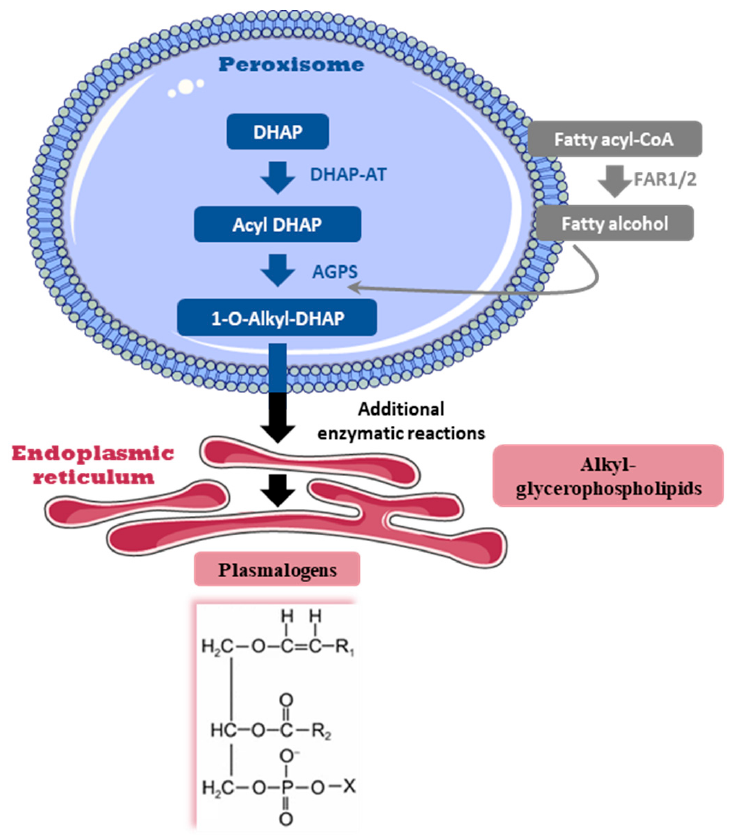
Figure 1. Schematic representation of plasmalogen biosynthesis. The biosynthesis of plasmalogens (Pls) is initiated in the peroxisome with three critical steps catalyzed by the enzymes FAR1 (fatty acyl-CoA reductase 1), DHAP-AT (dihydroxyacetone phosphate acyltransferase) and alkyl-DHAP synthase (alkylglycerone-phosphate synthase, AGPS). The biosynthesis of Pls is then continued in the endoplasmic reticulum by additional enzymatic reactions leading to the synthesis of alkyl- glycerophospholipid intermediates. The chemical structure of Pls is presented here. R1 denotes the carbon chain at the sn -1 position, and R2 at the sn -2 position. The polar head group, denoted by X, is most commonly choline or ethanolamine. acyl-CoA, acyl coenzyme